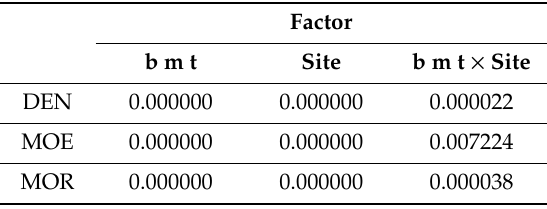
Table 4. Values of ANOVA (probability level for the significance test) for DEN, MOE and MOR, depending on the type of the log and its geographical